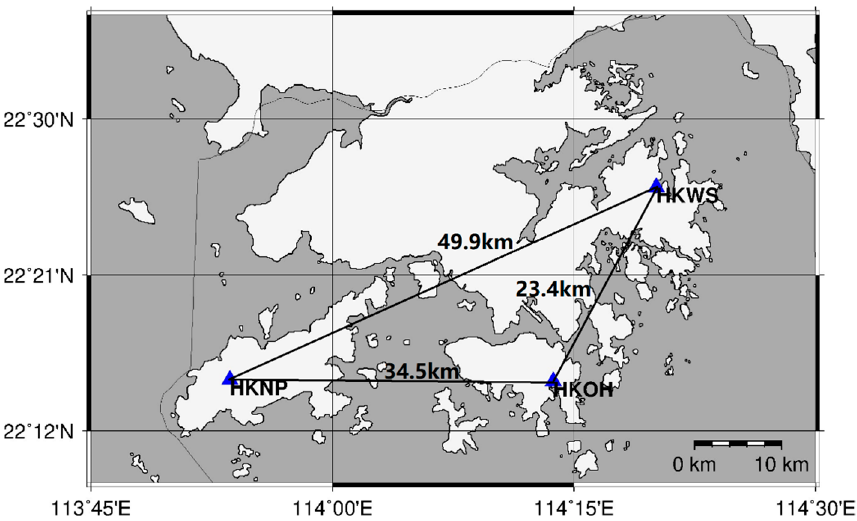
Figure 1. Selected reference station distribution of the Hong Kong CORS network.